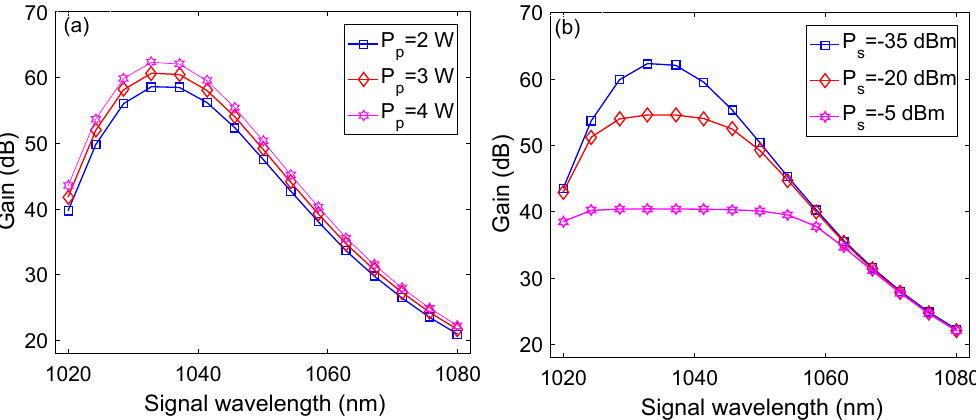
Figure 6. Signal wavelength versus gain plots at: ( a ) different pump powers; ( b ) different signal